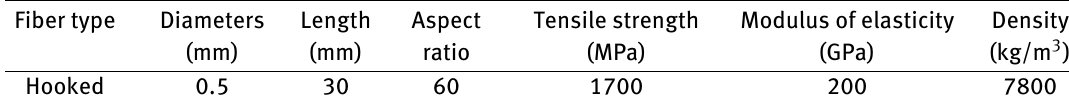
Table 2: Steel fiber characteristics Fiber type